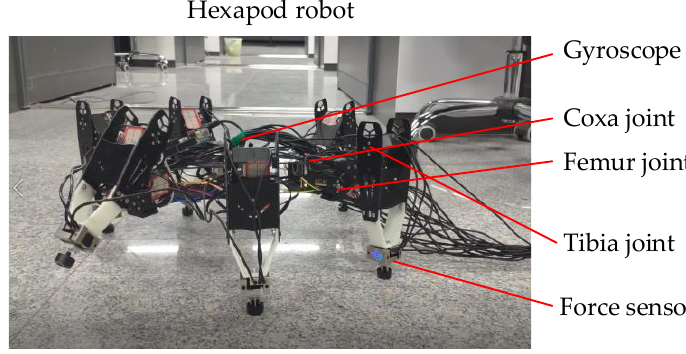
Figure 23. The test platform of the hexapod robot.